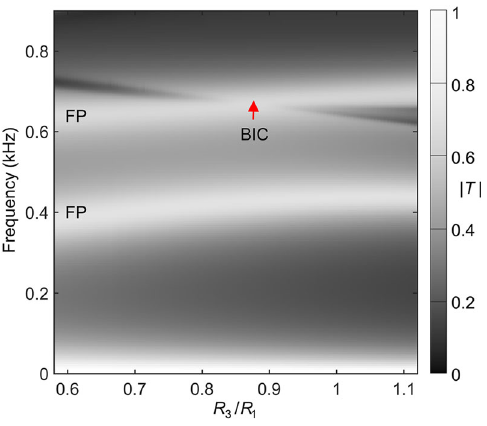
Fig. 10 Numerically obtained transmission spectrum | T | with viscous damping in the acoustic pipes are accounted for. As a result, the resonances around the BIC point are smeared out, but the overall qualitative behavior remains